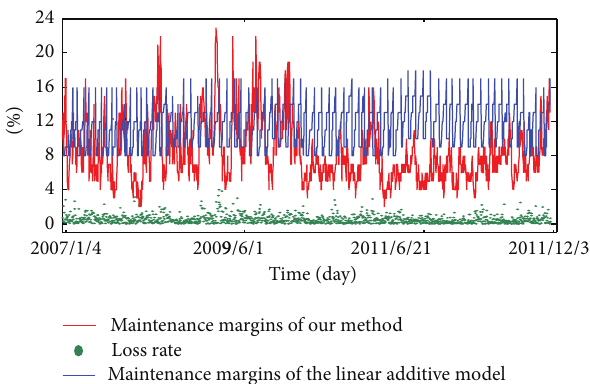
Figure 3: Comparison diagram of maintenance margins for Futures Portfolio A.